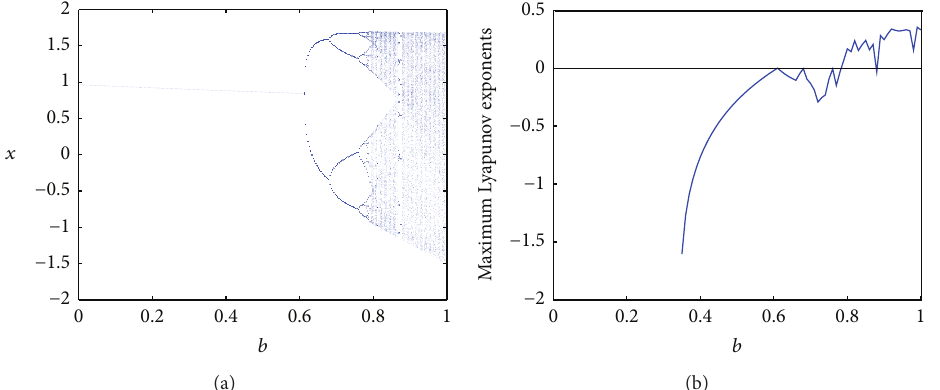
Figure 6: (a) Bifurcation diagram of map (2) in (𝑏,𝑥) plane for 𝑎 = 0.5 , 𝑐 = −0.1 , 𝑑 = −0.04 , and 𝑒 = 0.7 . (b) Maximum Lyapunov exponents corresponding to